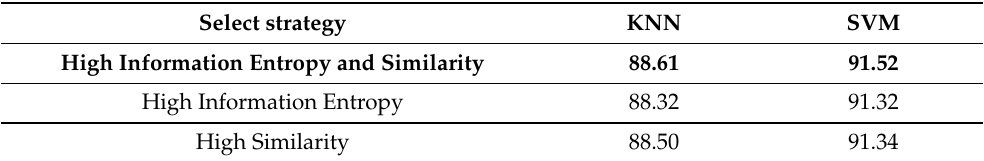
Table 4. AOA of two classifier on Salinas dataset (%). Our method is highlighted in bold. Select